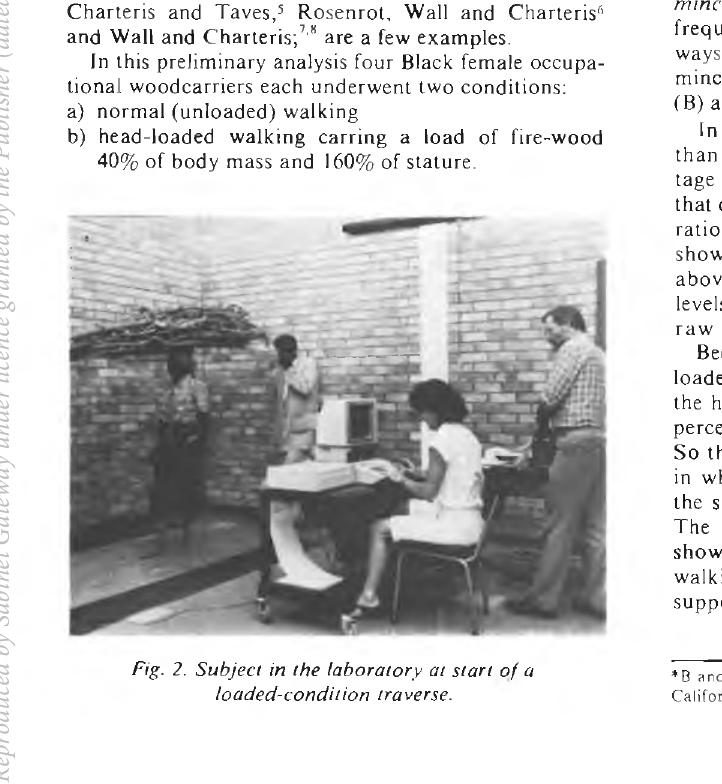
Fig. 2. Subject in the laboratory at start of a loaded-condition